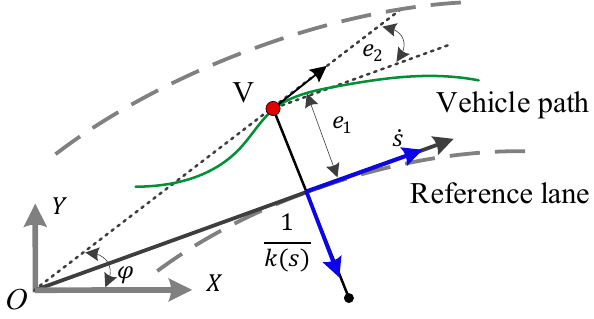
Figure 10. Notation used in NMPC planner.